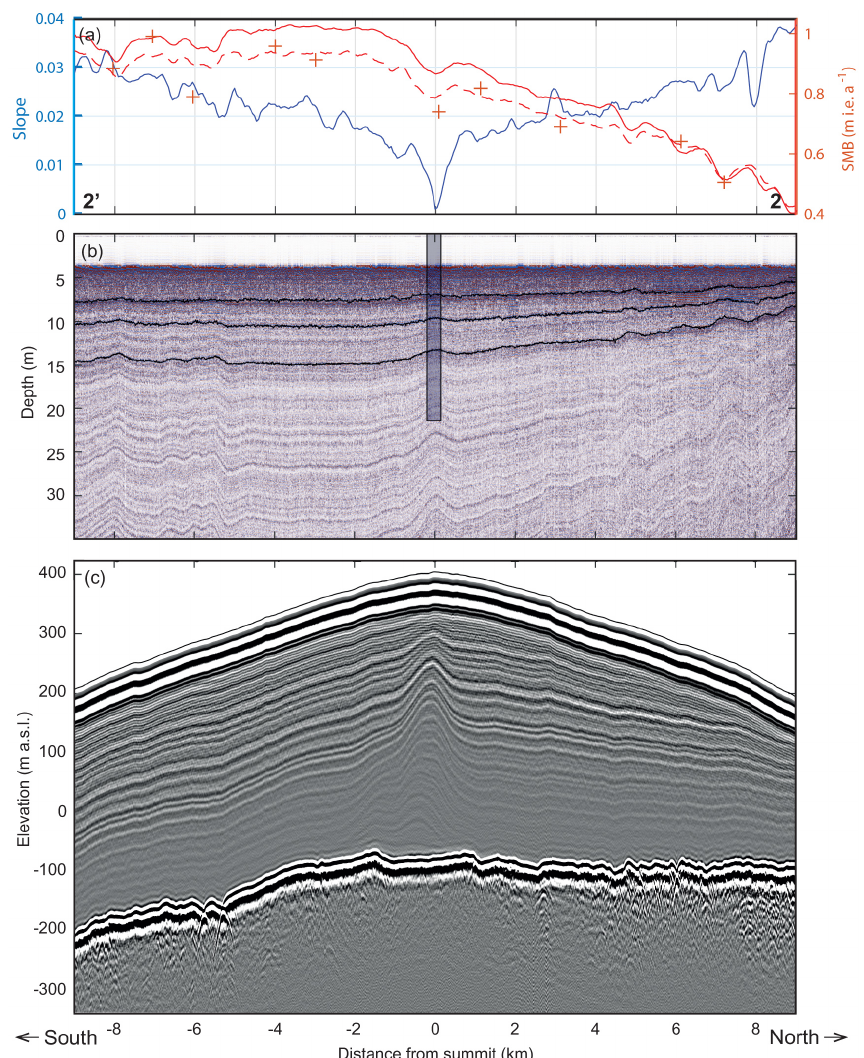
Figure 2. Cross sections of the ice rise along the flow line 2–2 (cid:48) (Fig. 1b). (a) Surface slope (500m running mean, absolute number, left axis) and SMB (right axis). The SMB derived from stake heights is indicated by + markers. Red curves show the two SMB estimates derived from radar data, with the solid curve assuming only vertical variability in density and the dashed curve accounting for both vertical and lateral variability in density. (b) 400MHz radargram. Three englacial reflectors are highlighted in black, which are dated with the 23m long firn core (vertical bar) and used to determine SMB. (c) 2MHz radargram. Data are shifted using the GPS-measured surface elevations to show the